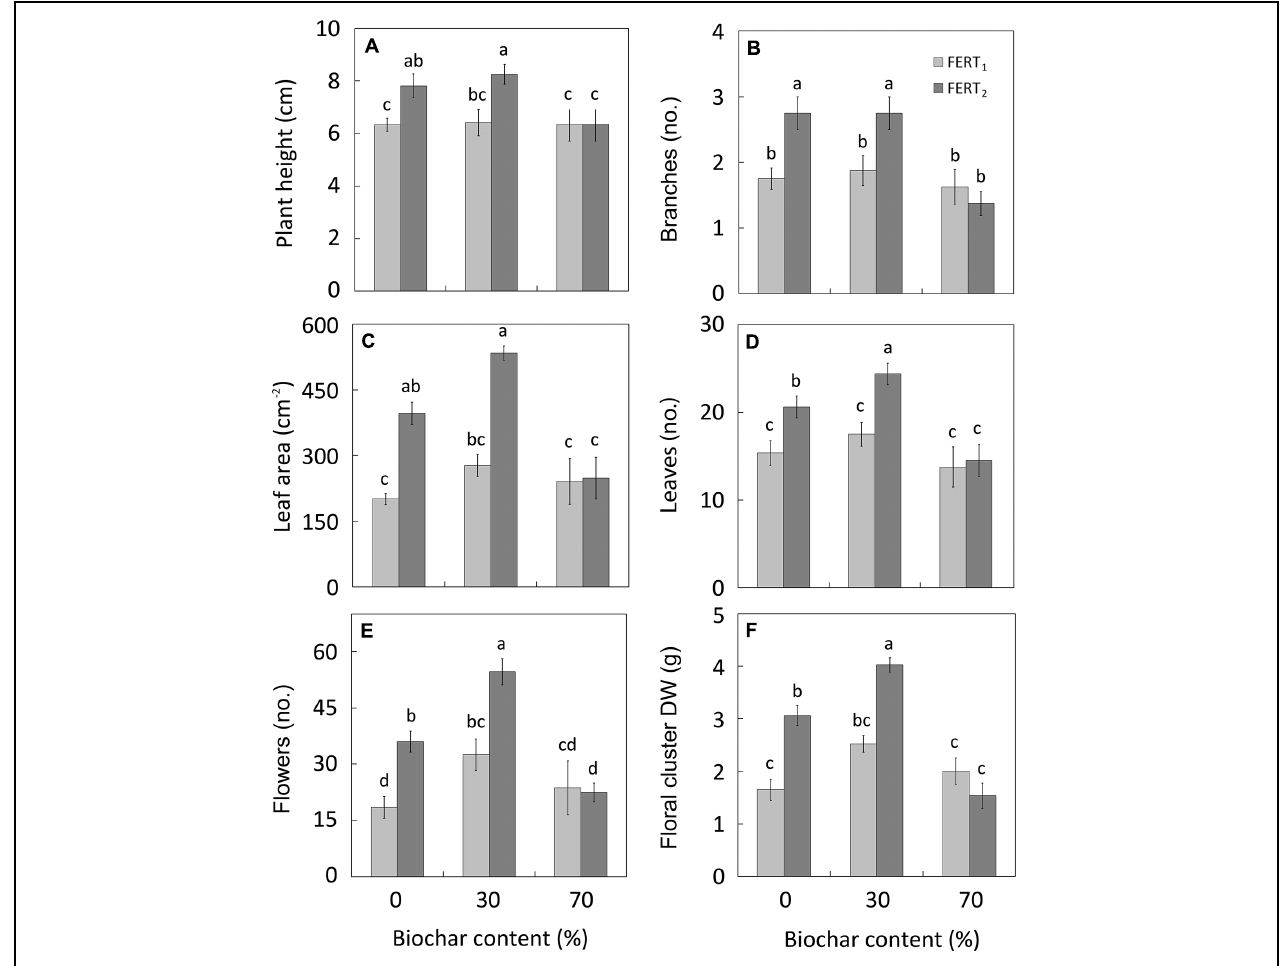
FIGURE 1 | Effect of peat:biochar ratio and fertilization rate on plant height (A), branch number (B), leaf area (C), leaf (D) and flower number (E), and floral cluster dry weight (F) of Pelargonium at the end of the experiment (74 DAT). Bars indicate standard errors ( n = 8). Treatments with